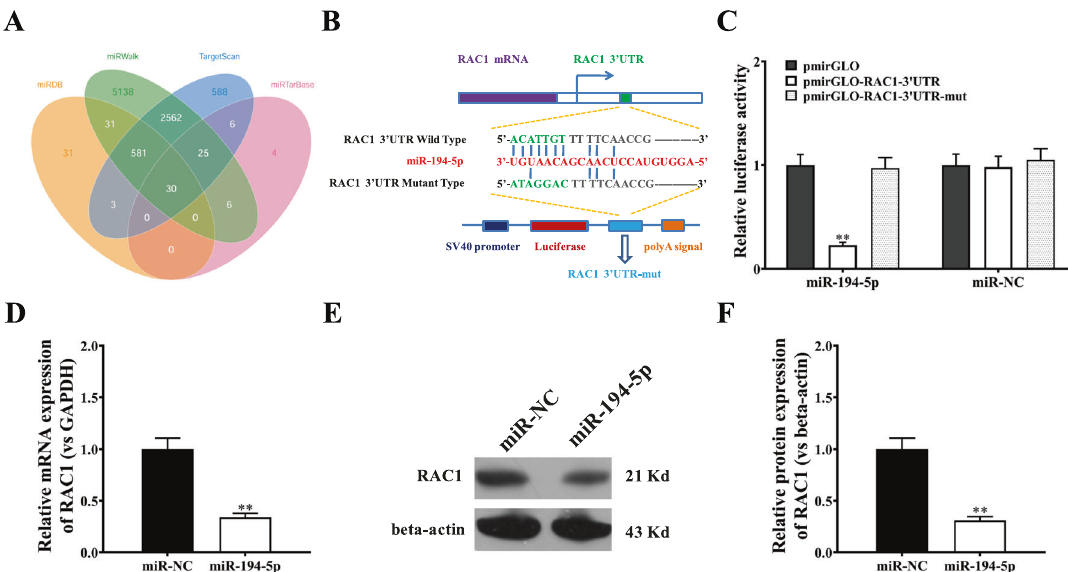
Fig. 5 miR-194-5p inhibits RAC1 expression. A Interaction network diagram between the miR-194-5p family and differentially expressed mRNAs using microRNA.org, star-Base v2.0, miRDB and TargetScan. B The predicted binding sites of miR-194-5p in the RAC1 3 ′ UTR. The red nucleotides are the seed sequences of miRNAs. The sequence of the RAC1 3 ’ UTR with wild-type (WT) versus mutant (mut) miR-194-5p target sites is shown. C Luciferase reporter activities of wild-type RAC1 3 ′ UTR, mutant RAC1 3 ′ UTR, and empty construct reporters in RAW264.7 cells overexpressing miR-194-5p. D Real-time PCR assay evaluated RAC1 mRNA expression in RAW264.7 cells transfected with miR-194-5p or miR- NC. GAPDH was used as the internal control. E Western blot analysis of RAC1 protein expression in RAW264.7 cells transfected with miR-194- 5p or miR-NC. Beta-actin was used as a referred protein. Data are representative of three biological replicates, and each experiment was performed at least three times independently. *, P < 0.05; **, P < 0.01 (t